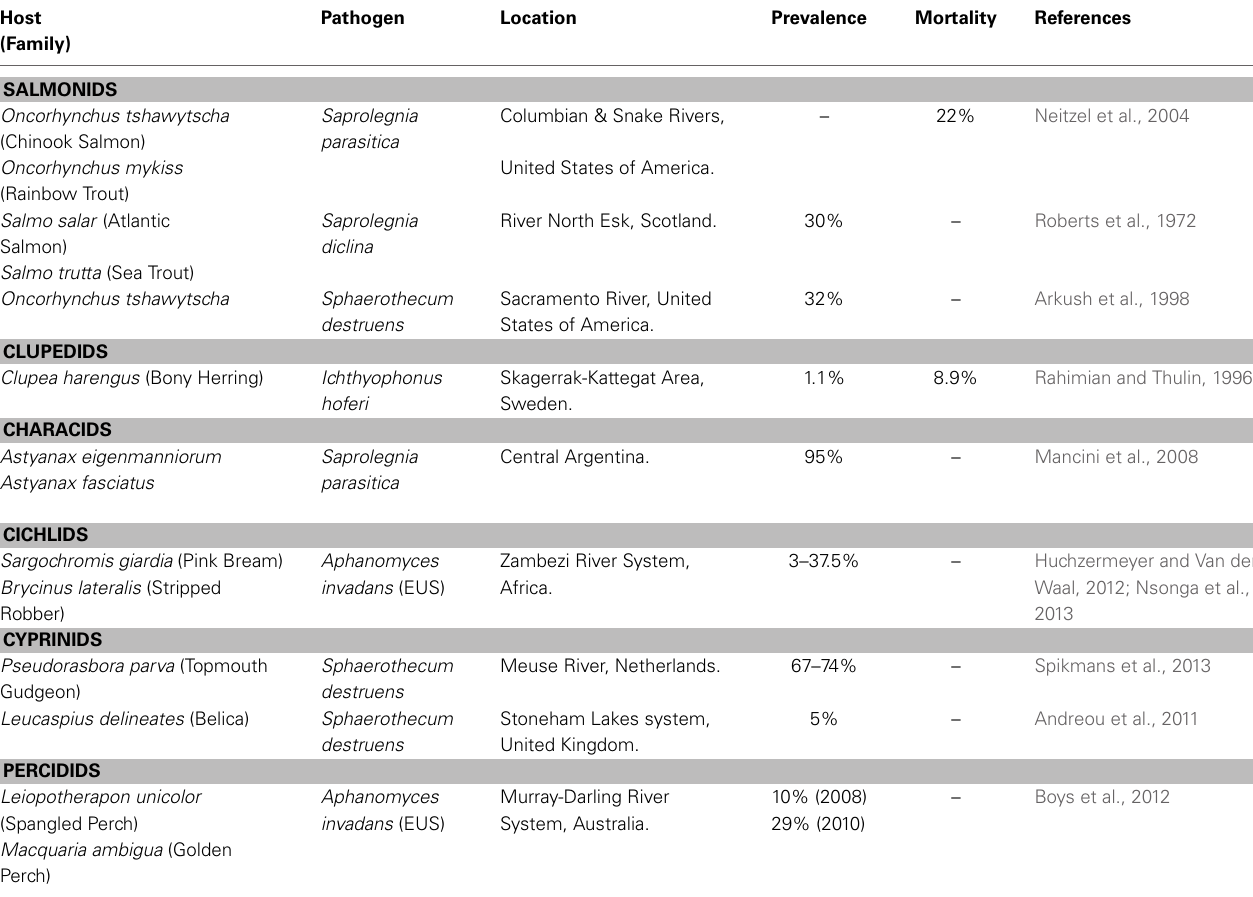
Table 2 | Example of fungal infections in wild fish